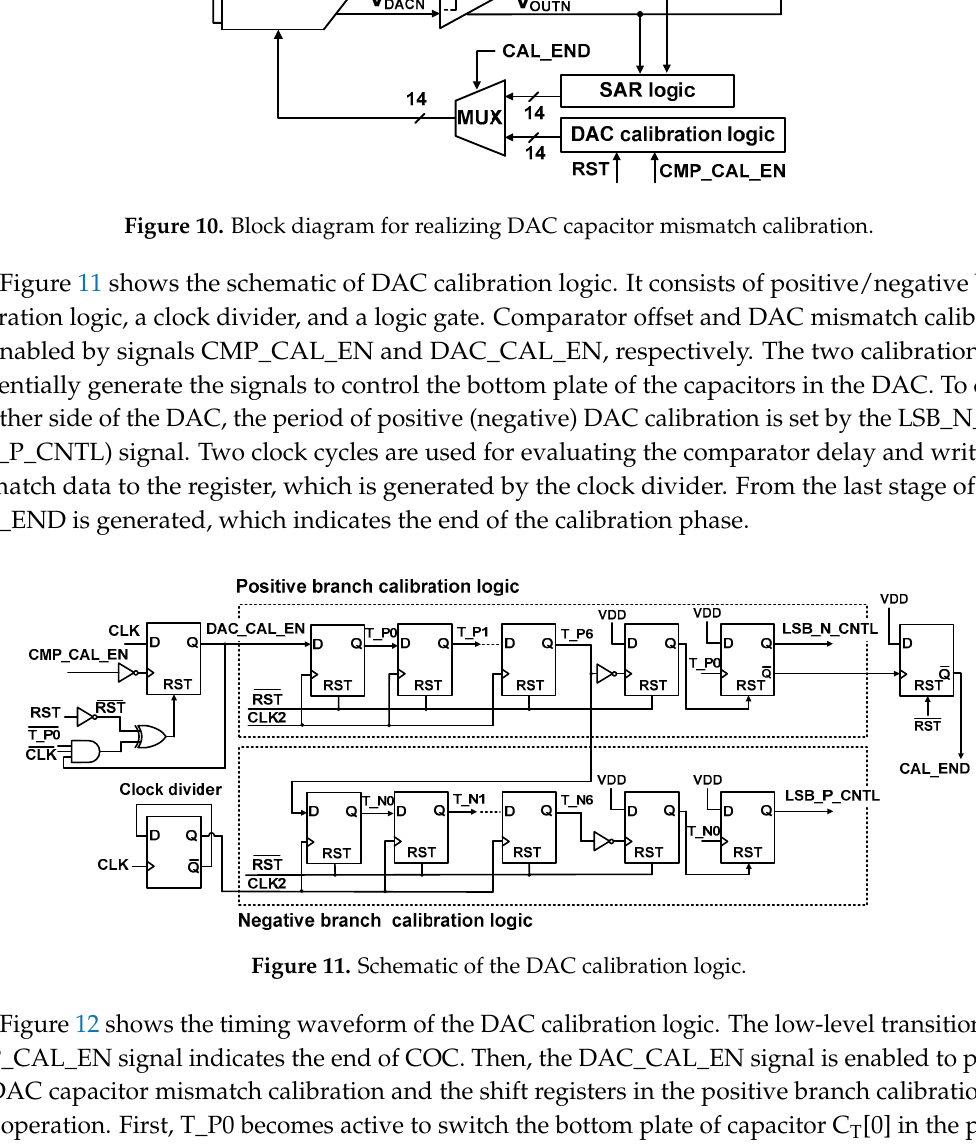
Figure 12. Timing waveform for DAC capacitor mismatch calibration.